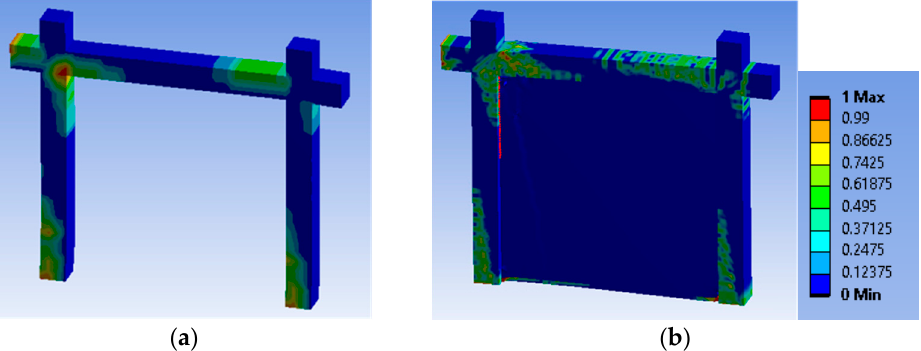
Figure 15. Concrete damage of ( a ) specimen A1F with 29% corrosion at total displacement 101.50 mm and specimen B2 with ( b ) 29% corrosion at total displacement 81.40 mm.